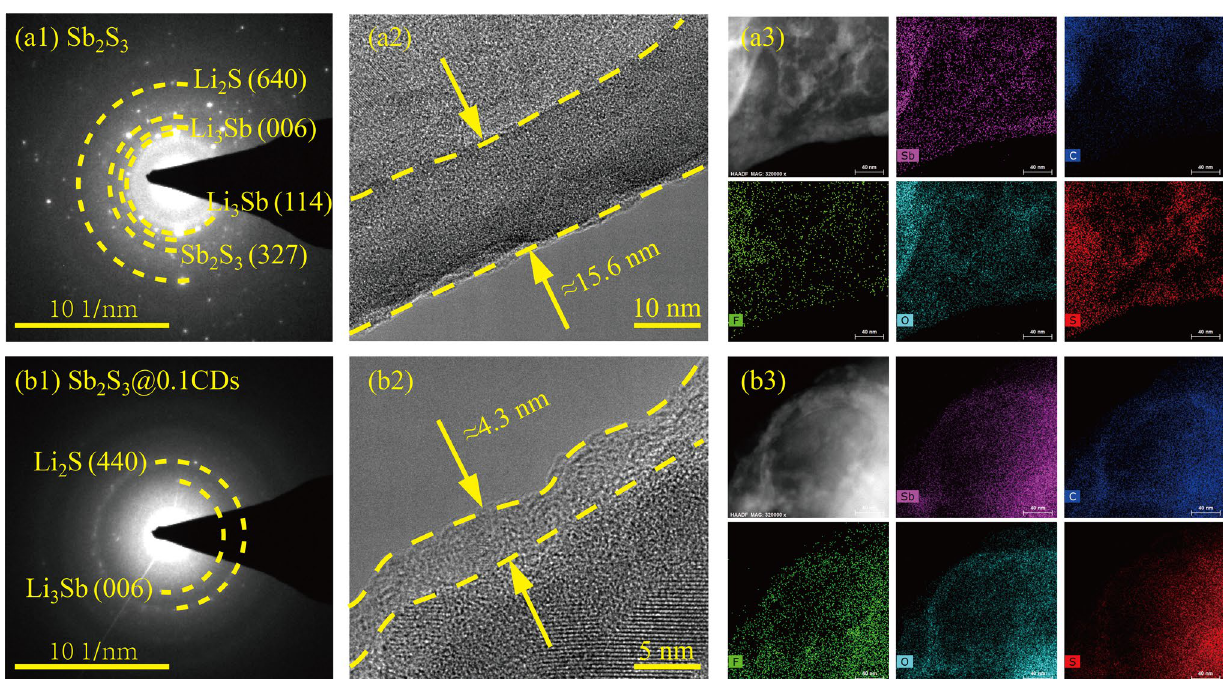
Fig. 7 SEI characterization. SAED patterns of ( a1 ) stibnite Sb 2 S 3 and ( b1 ) Sb 2 S 3 @0.1CDs. HRTEM of SEI formed on ( a2 ) stibnite Sb 2 S 3 and ( b2 ) Sb 2 S 3 @0.1CDs. The element mapping images of ( a3 ) stibnite Sb 2 S 3 and ( b3 ) Sb 2 S 3 @0.1CDs. All states are discharged to 0.01 V in the first